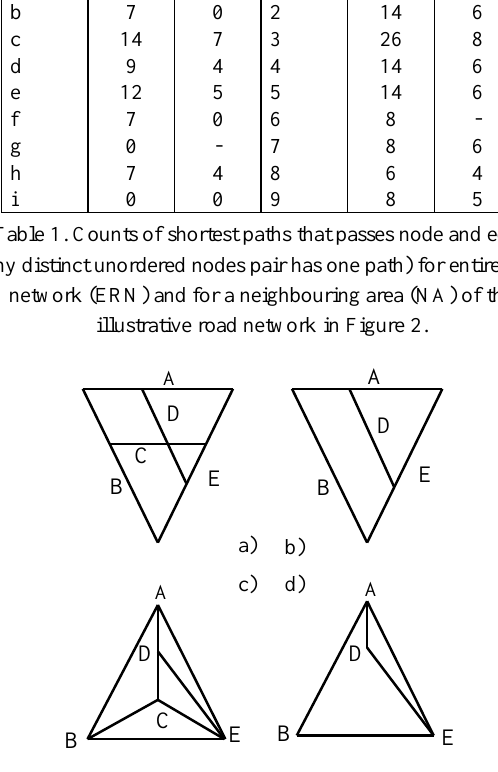
Figure 3. a) an example road network, b) the road network when